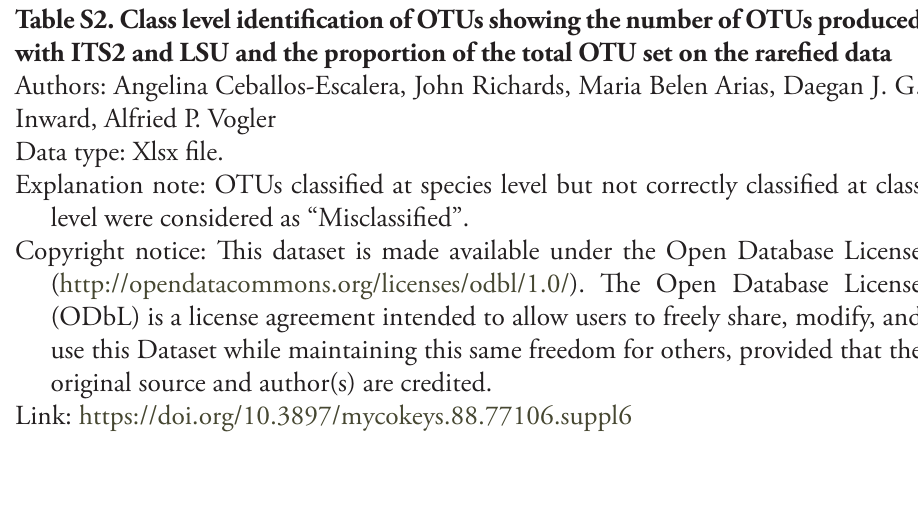
Table S2. Class level identification of OTUs showing the number of OTUs produced with ITS2 and LSU and the proportion of the total OTU set on the rarefied data Authors: Angelina Ceballos-Escalera, John Richards, Maria Belen Arias, Daegan J. G. Inward, Alfried P.